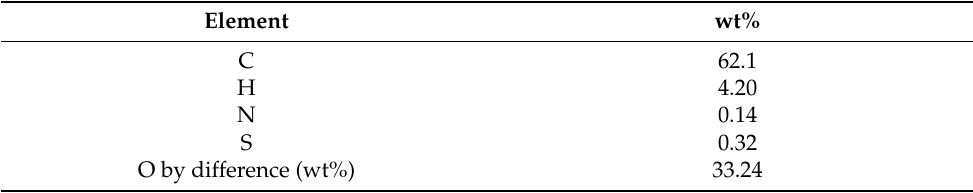
Table 1. Ultimate analysis of colorless PET waste